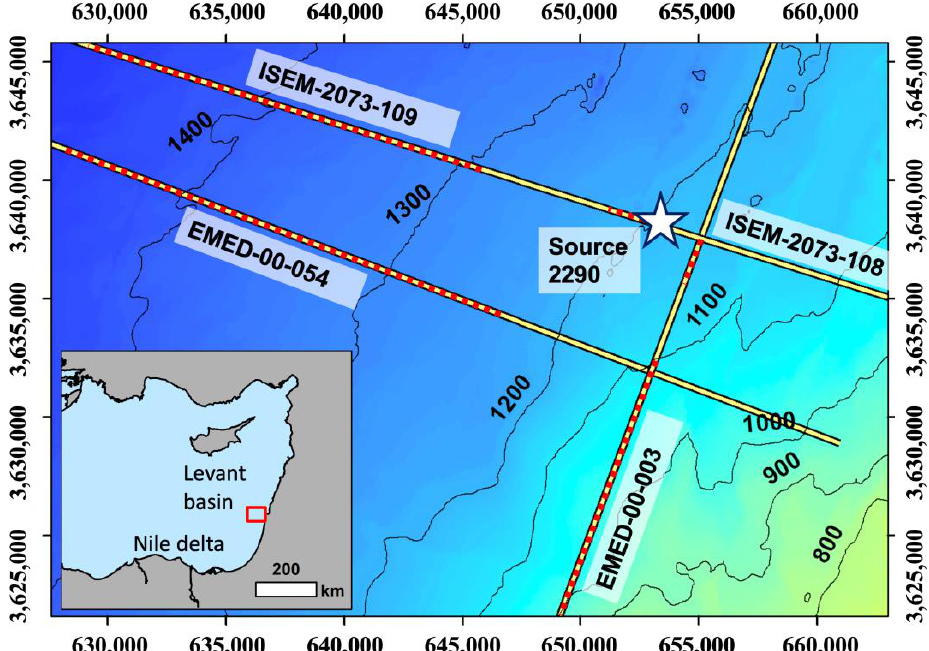
Figure 1. A bathymetric map of the studied area, overlaid with the outlines of the seismic lines (yellow lines). The analysis was carried out for areas with simple geological structures (red dashed lines). The location of source #2290 is depicted as a white star.